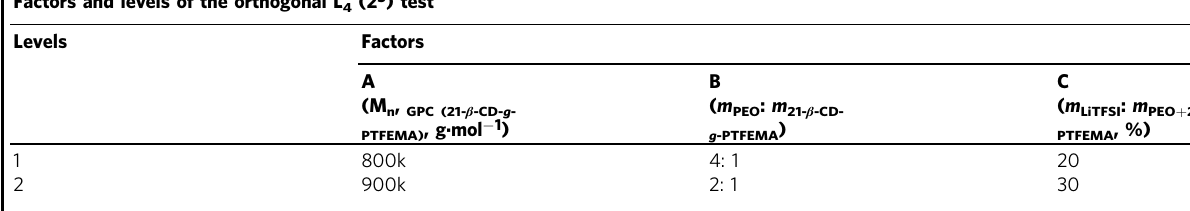
Table 1 The orthogonal experimental design and analysis for lithium metal batteries. Factors and levels of the orthogonal L 4 (2 3 ) test Levels